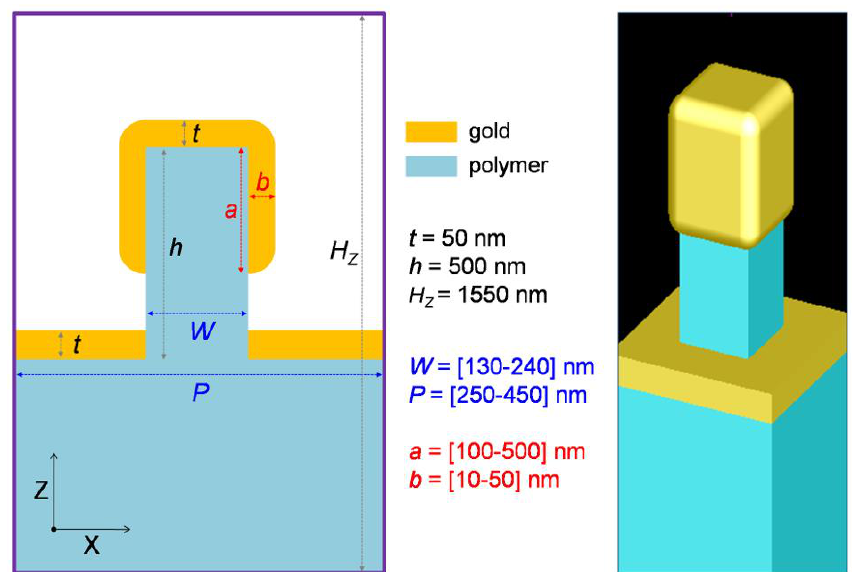
Figure 2. Geometry and parameters of the setup used for FDTD simulations: P — period of the array and width of the simulation cell along X and Y directions, H Z — vertical dimension of the simulation cell, h — height of the polymer nanopost, W — width of the nanopost, t — thickness of the gold film, a — length of nanopost covered by gold, in case of partly covered nanoposts, and b — thickness of the gold film on the sides of the nanopost.